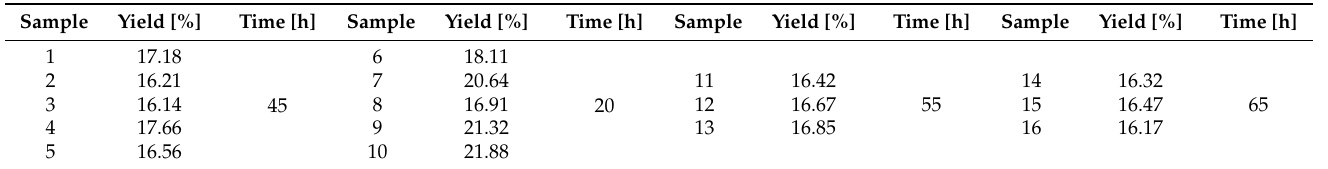
Table 4. Results of removal of proteins using 5 M NaOH